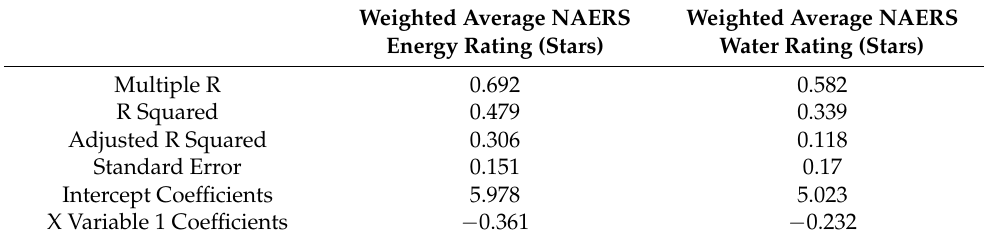
Table 7. Regression results of environmental rating features.